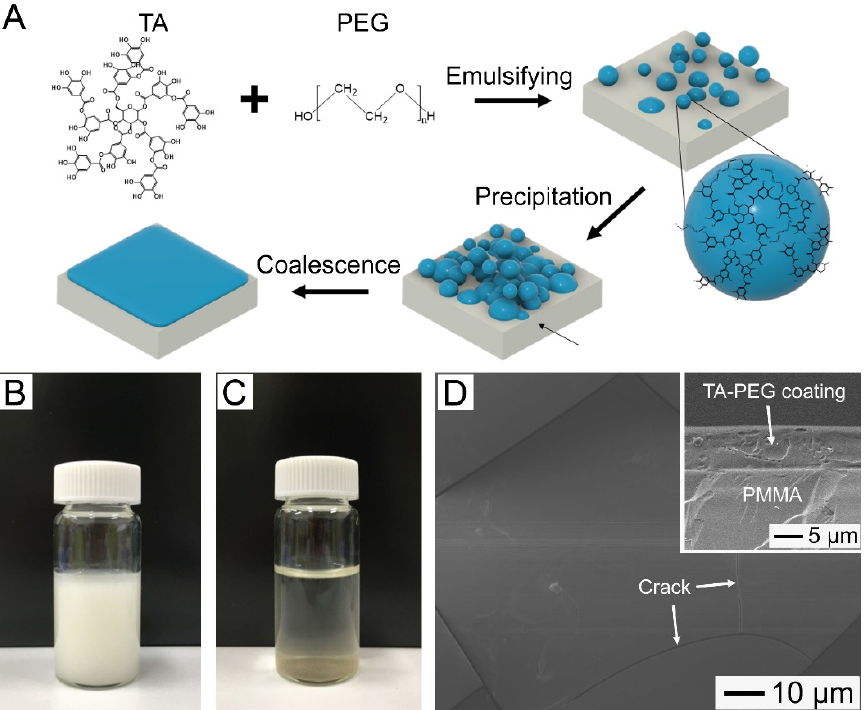
Figure 1. ( A ) Schematic illustration of the procedure for preparing an antibacterial coating layer with self-healing and drug-releasing capabilities. ( B , C ) Photographs of the TA-PEG emulsion containing NaCl (1 M) taken: ( B ) Immediately and ( C ) at 60 min after mixing TA (10 mg/mL) and PEG (2 mg/mL, M W = 100 kDa) aqueous solutions. ( D ) SEM image of the PMMA substrate incubated with the emulsion of ( B ) for 120 min. The inset shows a cross-sectional SEM image of the substrate.